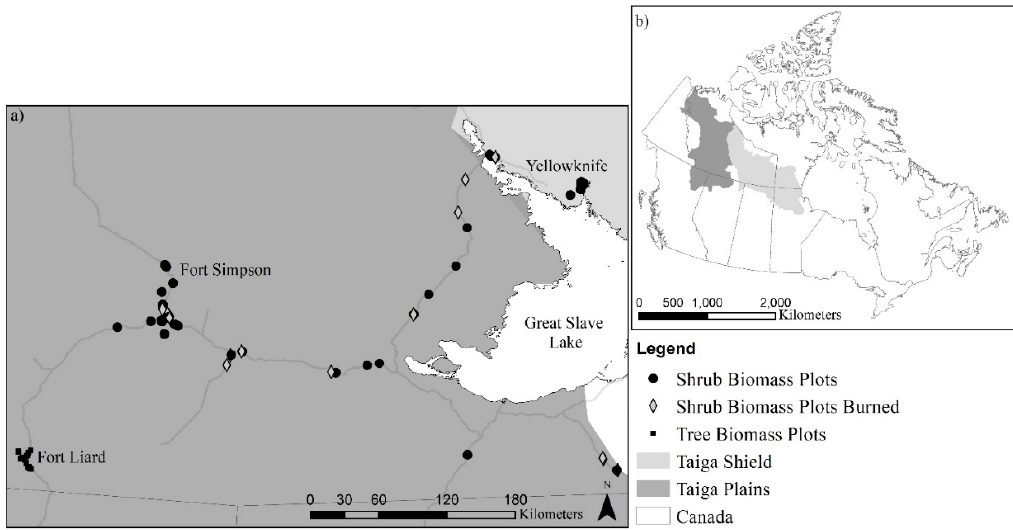
Figure 1. ( a ) Field locations of destructive sampling of shrub and short-stature tree AGB in peatlands and upland forest ecosystems. Field locations are distributed across the ( b ) mid-boreal Taiga Plains and high-boreal Taiga Shield ecoregions of the Northwest Territories, Canada.